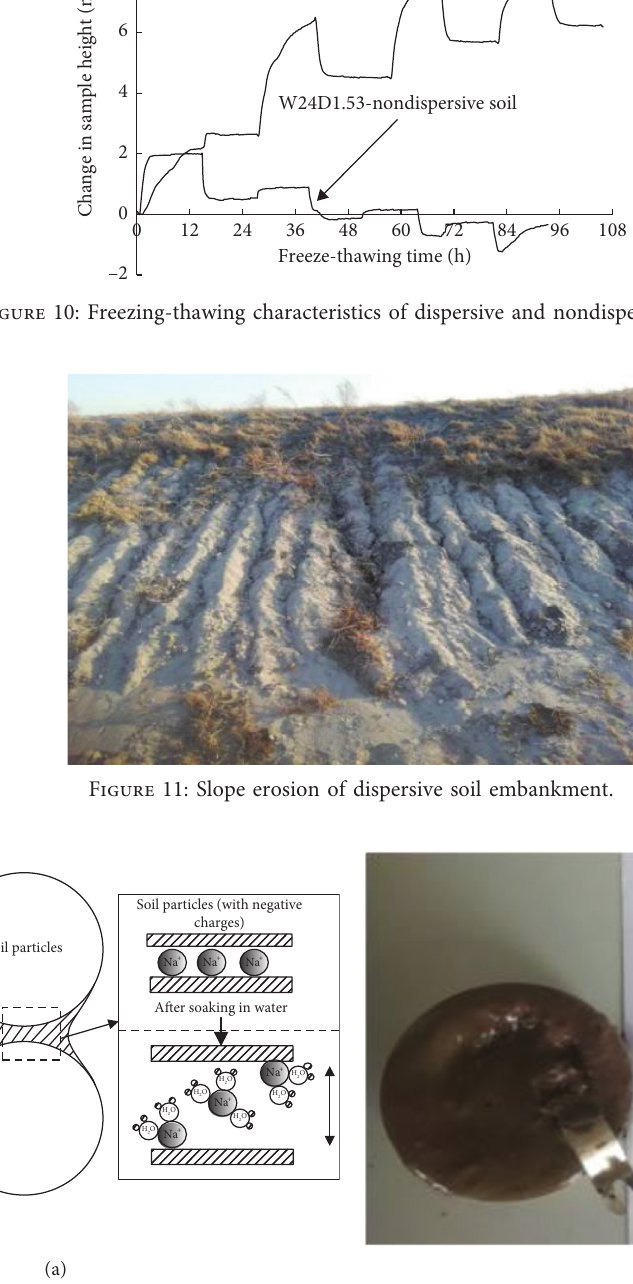
Figure 12: State of dispersive soil after freezing-thawing and soaking. (a) Dispersion mechanism of dispersive soil particles in water after freeze-thawing and soaking and (b) dispersive soil sample state after 4h freeze-thawing and